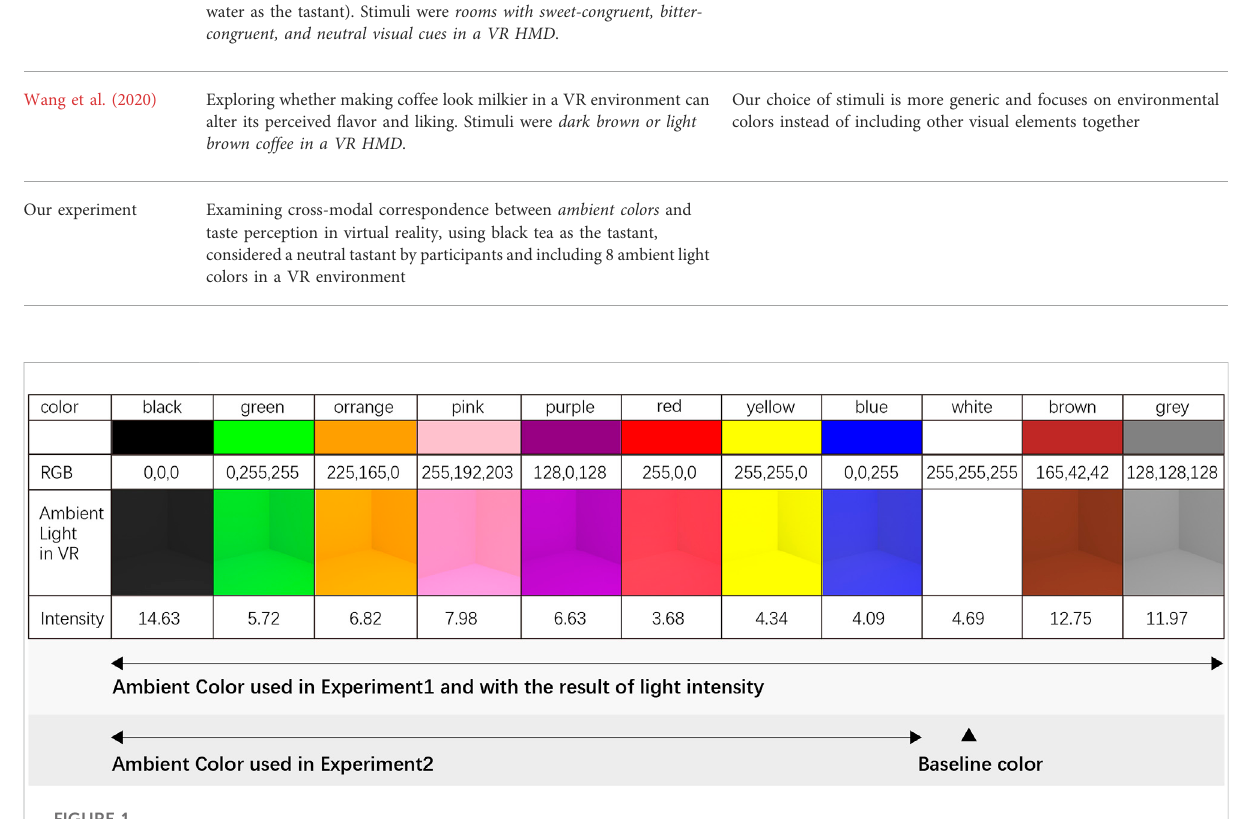
FIGURE 1 Ambient colorstimulithatwereutilizedinthisstudy,withtheirRGBvalues,ambientlighteffectsinVR,andthesuitable lightintensities obtained from Experiment 1. The fi rst row with an arrow represents the colors tested in Experiment 1. The second row indicates the colors in Experiment 2, with white as a baseline color.